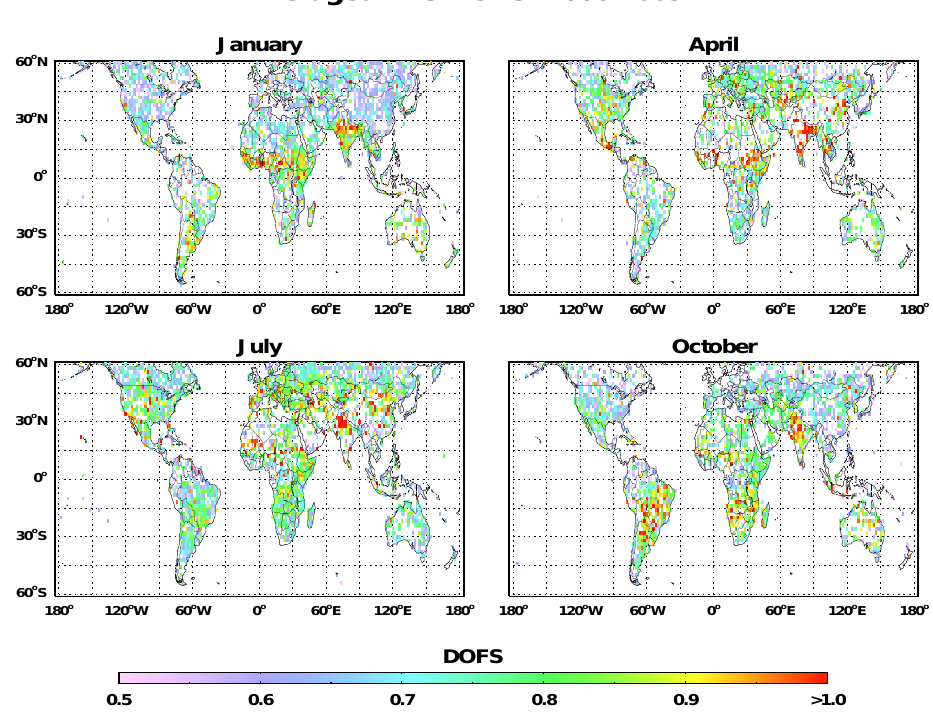
Fig. 20. The TES retrieval degrees of freedom averaged over the 2 × 2.5 ◦ boxes corresponding to the RVMR values in Fig. 11.